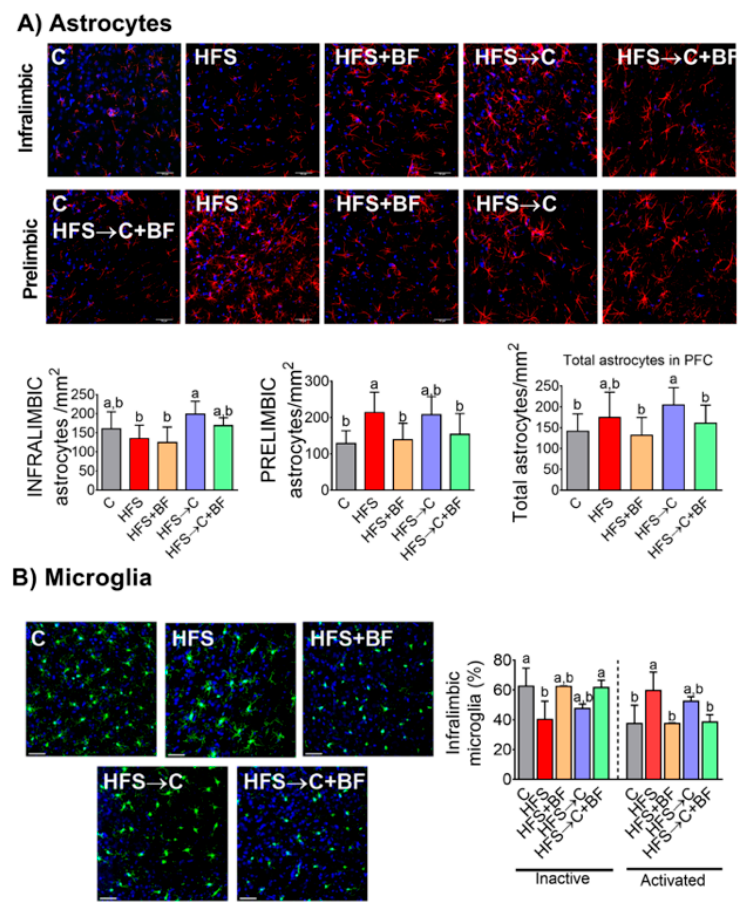
Figure 11. Astrocytes and microglia in prefrontal cortex were modified by bioactive foods. ( A ) Rep- resentative images of astrocytes in infralimbic and the prelimbic areas of prefrontal cortex and quantification and ( B ) representative images of microglia in infralimbic area of prefrontal cortex and quantification of activated or inactivated cells of rats fed control ( C ) or high fat diet + 5% sucrose (HFS) with or without bioactive foods. Data are expressed as the mean ± SD. Mean values with different letters show statistical differences between each other. Data were analyzed by one-way ANOVA followed by Tukey post-hoc test. Results were considered statistically significant at p < 0.05.